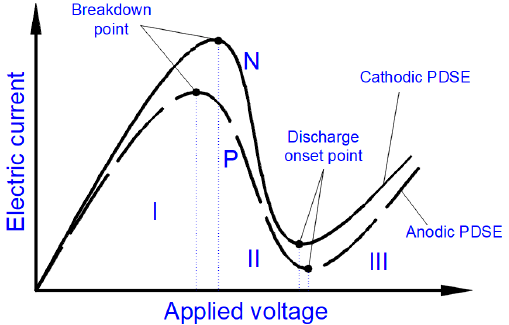
Figure 5. A typical shape of the current-voltage characteristics of the electrolysis. The characteristics shown correspond to two cases: positively (P) and negatively (N) charged smaller electrode. The first case terminates with the anodic regime of PDSE. The second terminates with the cathodic regime of PDSE. Voltage regions: I—the Faradaic electrolysis (starting from 0 V and terminating at the breakdown point), II—the transition region (starting from the breakdown point and terminating at the discharge onset point), III—the anodic and cathodic regimes of PDSE (initiating at the discharge onset point). The experimental current-voltage characteristics can be found in [20,36,38,40–44].